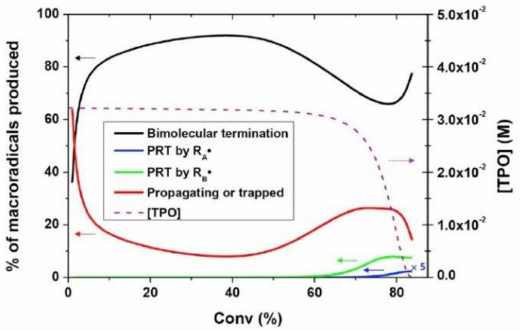
Figure 22. Evolution of the fractions of terminated species, propagating or trapped macroradicals (left scale) and TPO concentration (right scale) as a function of the acrylate